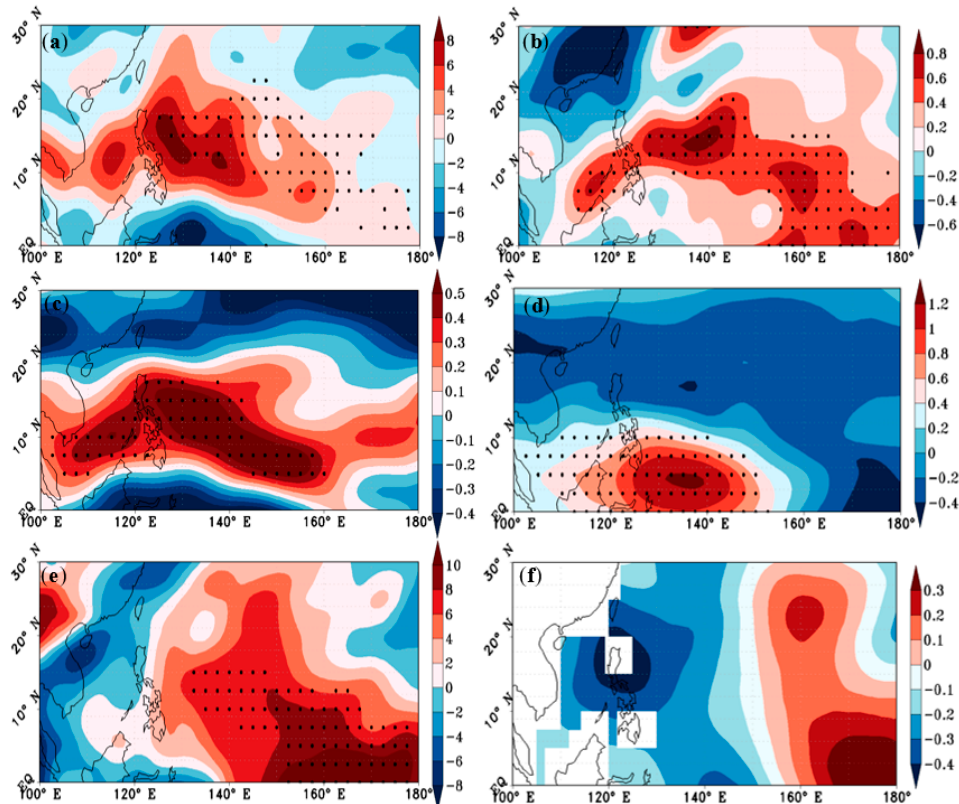
Figure 4. Differences in environmental factors in years with high and low TC frequency: ( a ) 850 hPa absolute vorticity (unit: 10 − 6 s − 1 ); ( b ) 500 hPa vertical velocity (unit: − 10 − 1 Pa s − 1 ); ( c ) meridional gradient of zonal wind at 500 hPa (unit: s − 1 ); ( d ) vertical wind shear (unit: m s − 1 ); ( e ) 600 hPa relative humidity (%); ( f ) sea surface temperature (unit: °C). The values in black dots are significant at a 95% confidence level.